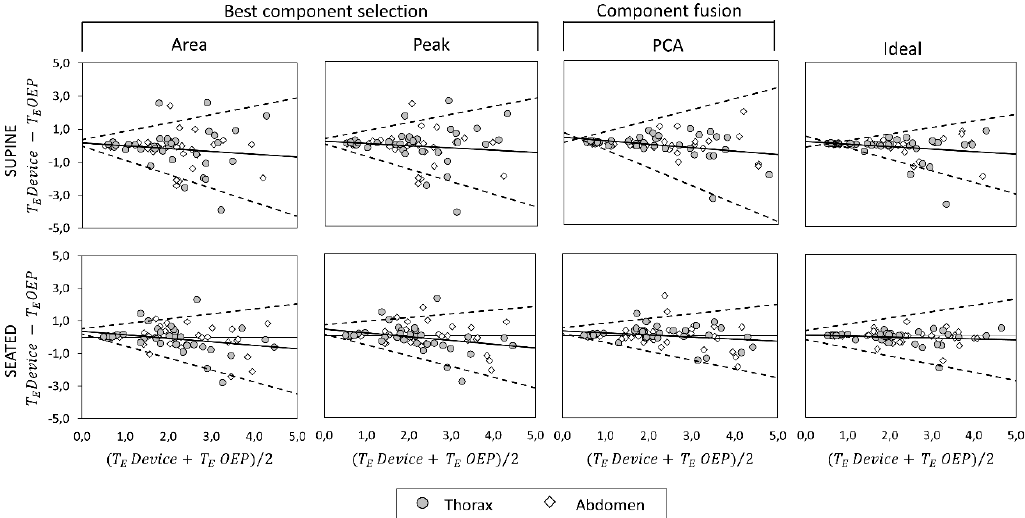
Figure 10. Agreement analysis between OEP and the IMU-based device for expiratory time (T E , [s]) measurements, in supine (top panels) and seated (bottom panels) position. In each Bland–Altman plot the differences between measurements of T E obtained by using the IMU-based device and by using OEP are plotted against the mean of the two measurements. For homoscedastic data, the mean of the differences (bias: —) and limits of agreement (- - -) from mean − 1.96 s to mean + 1.96 s are represented by lines parallel to the X axis. For heteroscedastic data, the proportional bias (—) is represented by the OLS line of best fit for differences on mean values; V-shaped upper and lower 95% confidence limits (- - -) are calculated according to Bland [44].